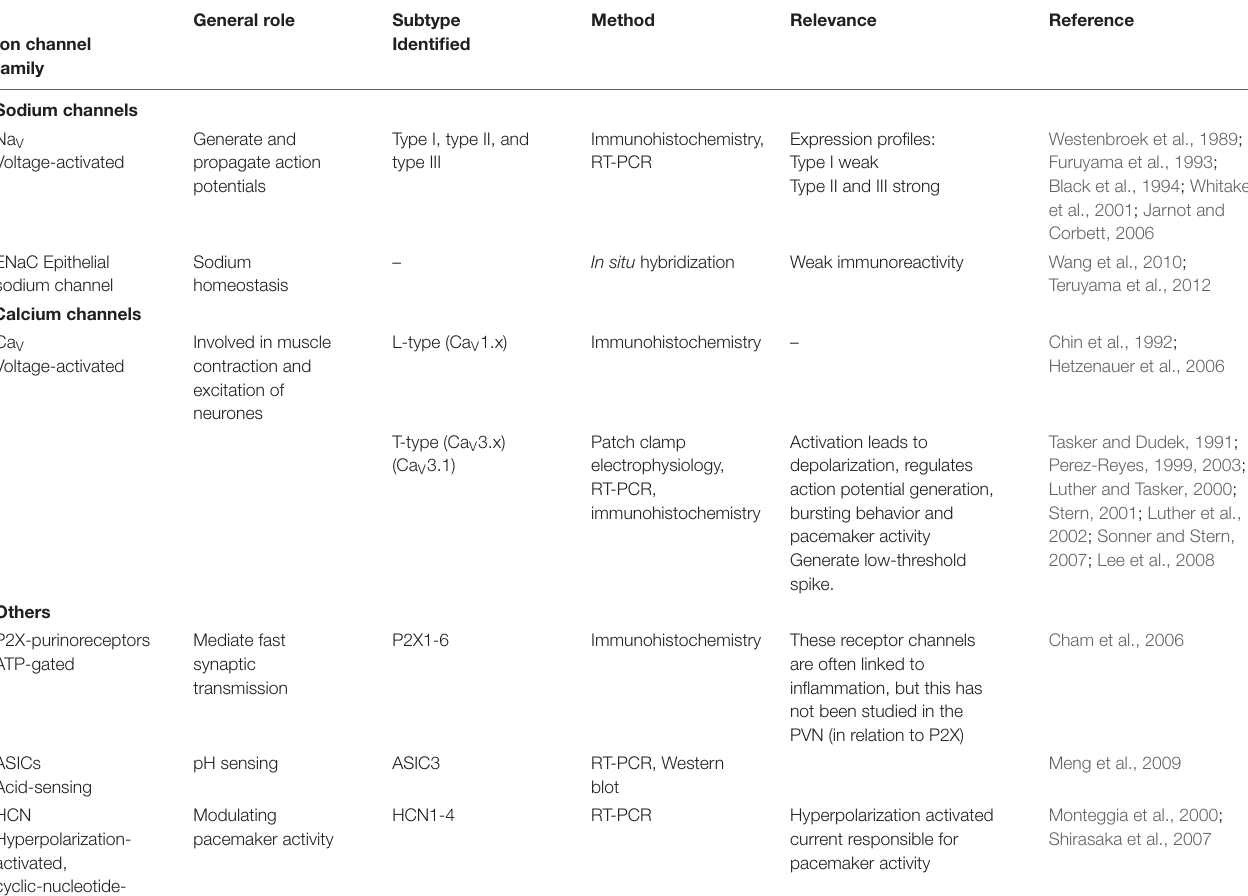
TABLE 4 | Other channels in the